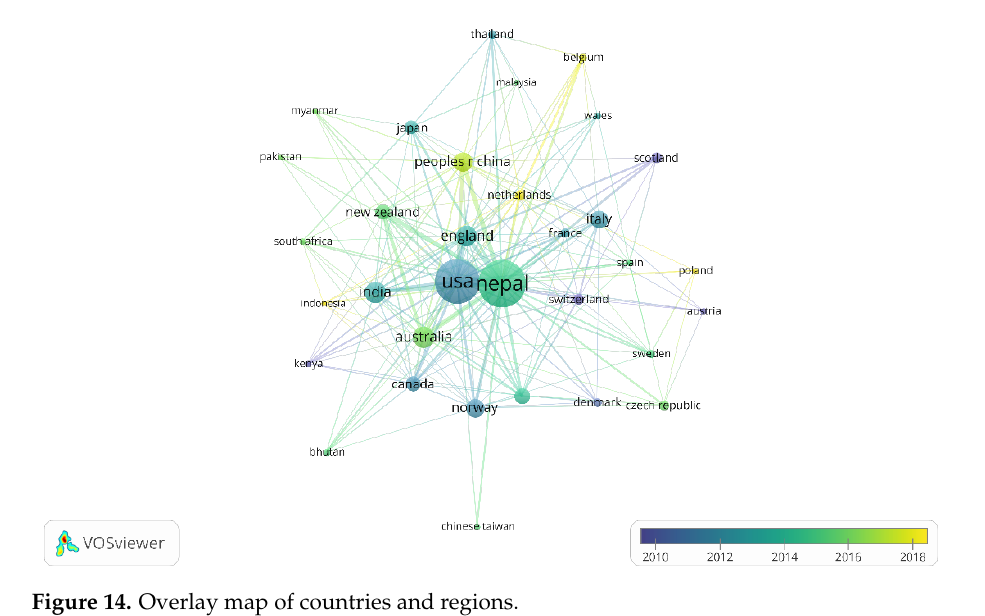
Figure 14. Overlay map of countries and regions.